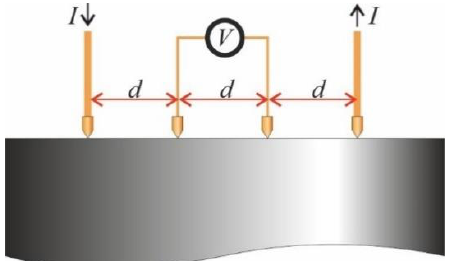
Figure 3. Representation of the four points probe for the electrical resistance measurements. For convenience, the distance between electrodes is the same ( d ). The electrodes are connected to a Kelvin bridge, which supplies the ratio V / I (with electrical resistance dimensions, R measured ) used to calculate the electrical resistivity.